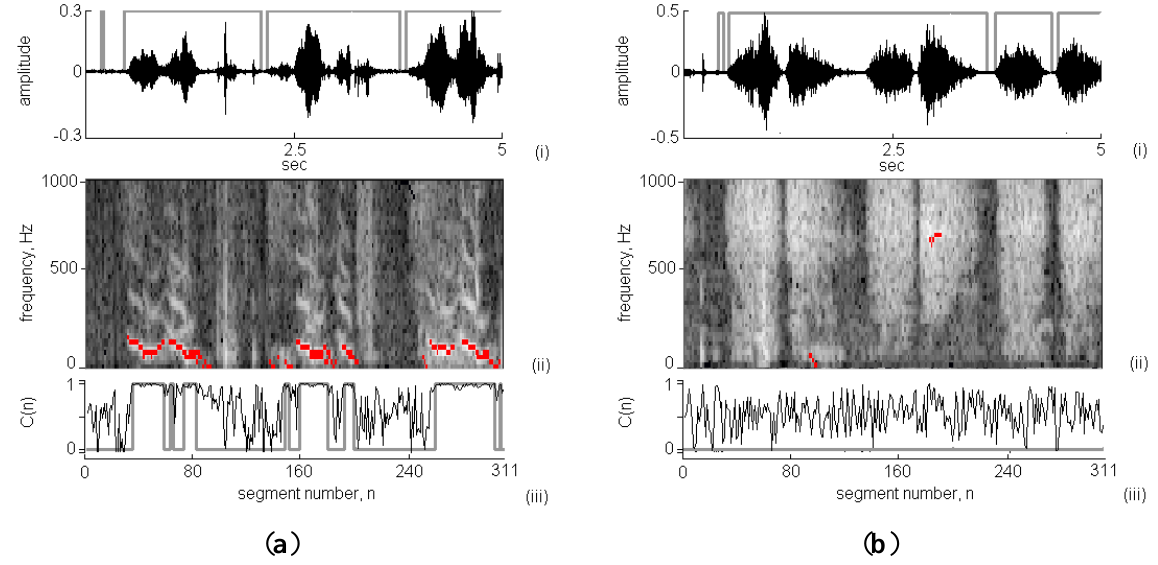
Figure 6. Two clinical respiratory sounds analyzed by RSACC and TF-WD ( a ) concerns the case of wheeze by patient p1 and ( b ) concerns the case of non-wheeze by patient p2.